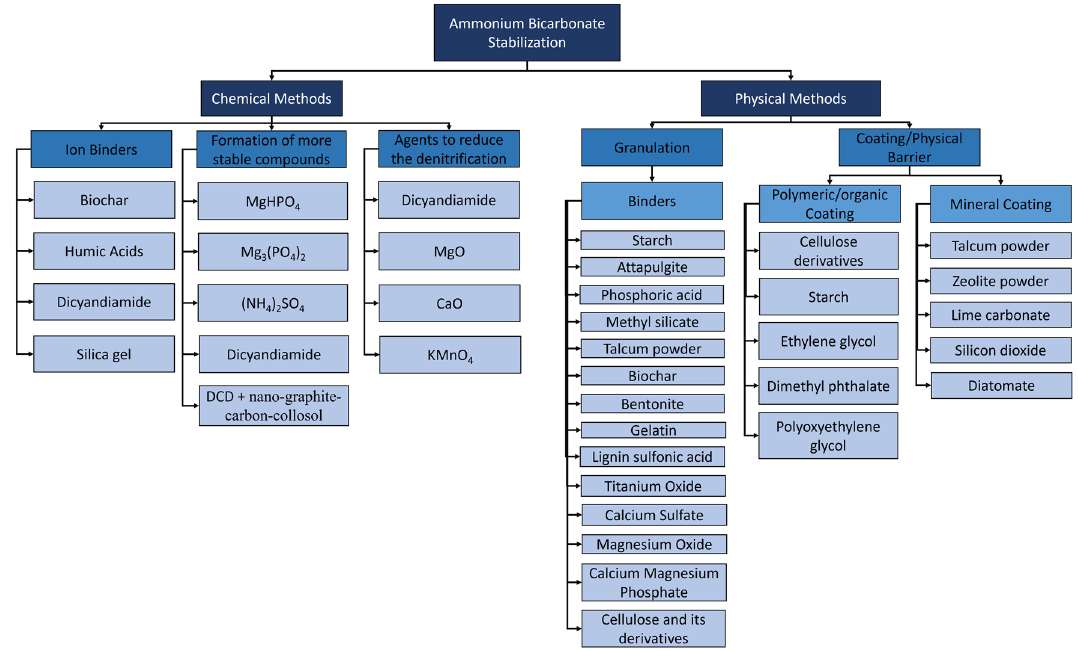
Figure 3 . The main methods and additives applied to increase ammonium bicarbonate stability. Compiled from [46–56] .